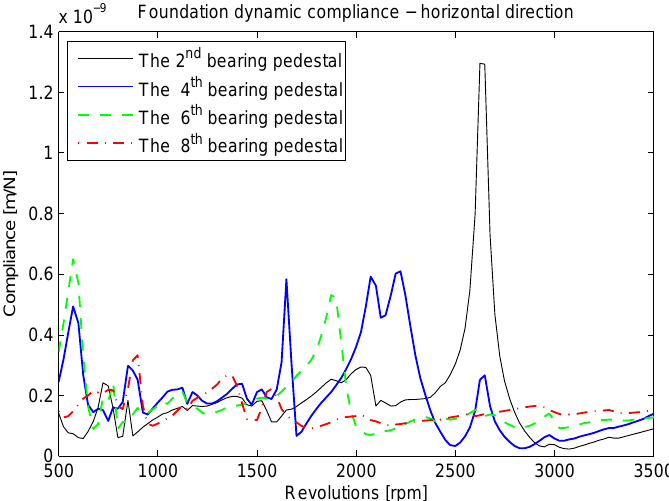
Figure 7. Modules of dynamic compliances of the chosen bearing pedestals used for model B in the horizontal direction.